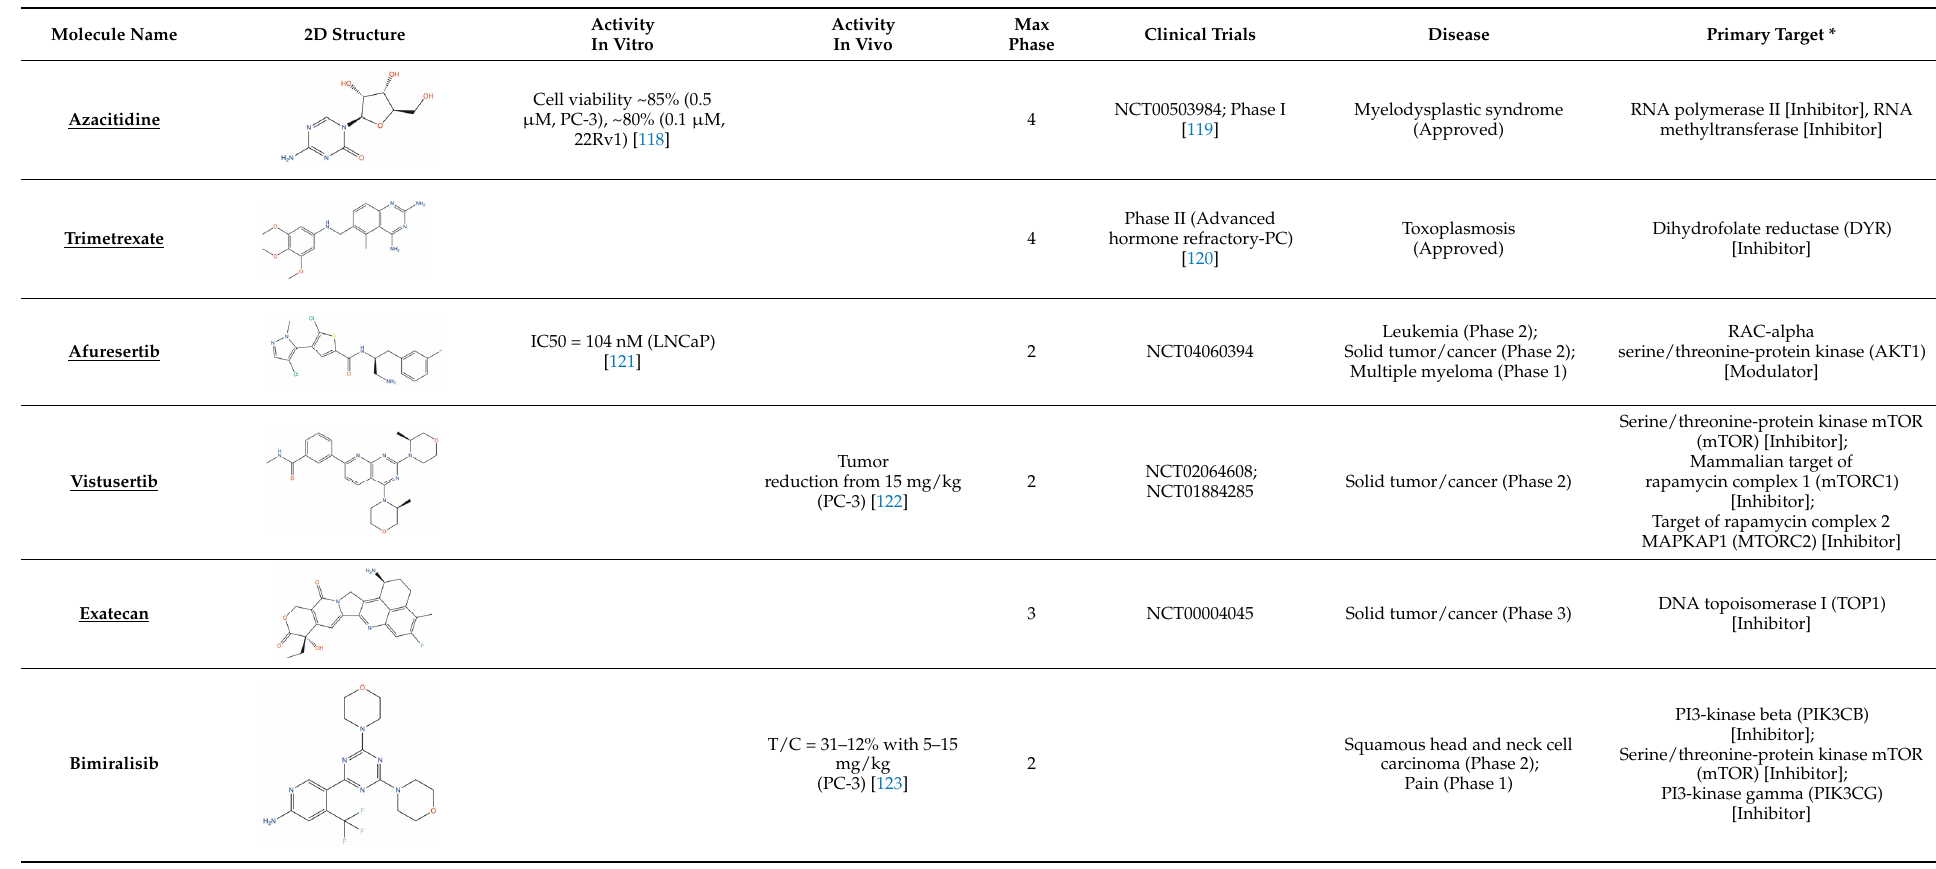
Table 2. Compounds identified from the similarity screenings and relevant association to PC, proposed as potential repurposing candidates. The first 5 compounds underlined in the table have already completed or are currently enrolled in clinical trials against PC. “Max Phase” was obtained from ChEMBL. “Disease” and “Primary target” were obtained from TTD. “Primary target” also contains the target UniProt name and the molecule’s mechanism of activity on the target in square brackets.